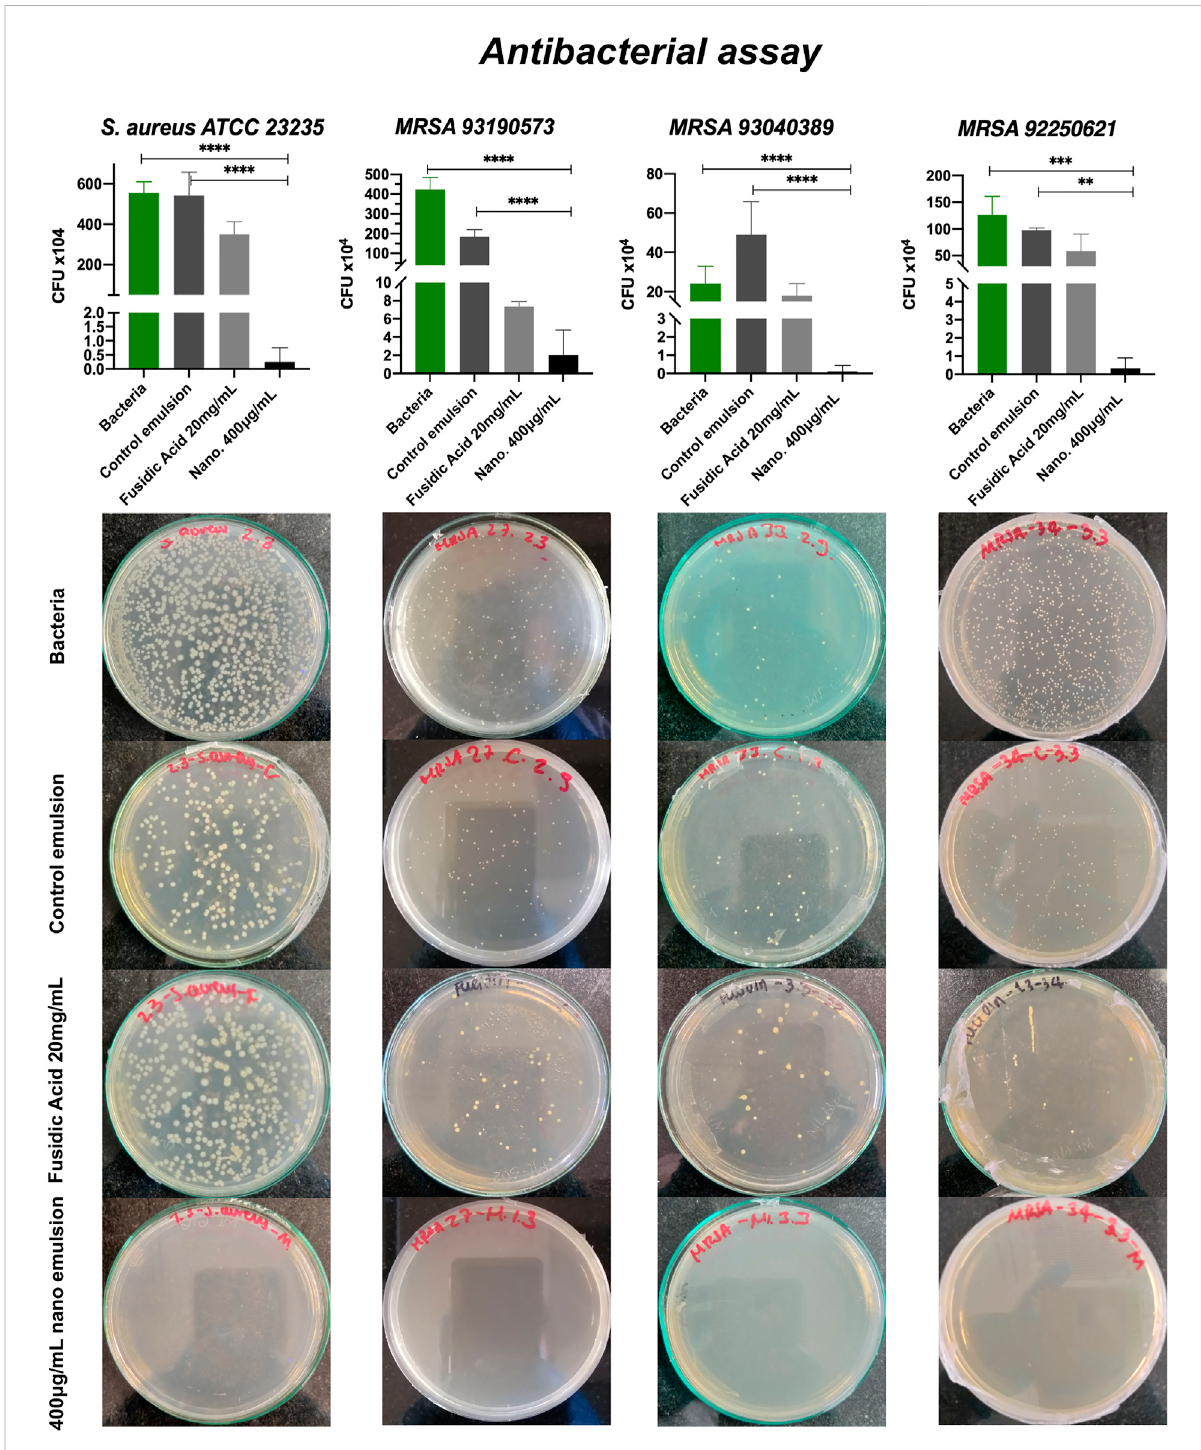
FIGURE 7 Antibacterial activity assay performed with S. aureus (ATTC 23235) and MRSA clinical isolates (92250621, 93040389 and 93190573). The emulsion tested was prepared with the MNP-PEG8-BUF-II-Ag nanobioconjugates (400 μ g/ml) at 60% wt. and HLB of 14. The emulsion prepared in the absence of the nanobioconjugates and a commercial topical based on fusidic acid (20 mg/ml) wereemployedas controls in the assay. The third dilution (1 × 104 CFU) was seeded. The positive control was bacteria grown in Na2HPO4 buffer. (****) corresponds to p < 0.0001, (***) to p < 0.001 and, (**) p < 0.01. Statistically signi fi cant differences were for p <